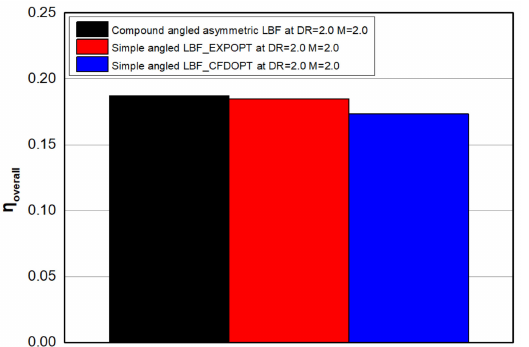
Figure 16. Comparison of FCE in the compound angled asymmetric laidback fan shaped hole and the simple angled symmetric laidback fan shaped